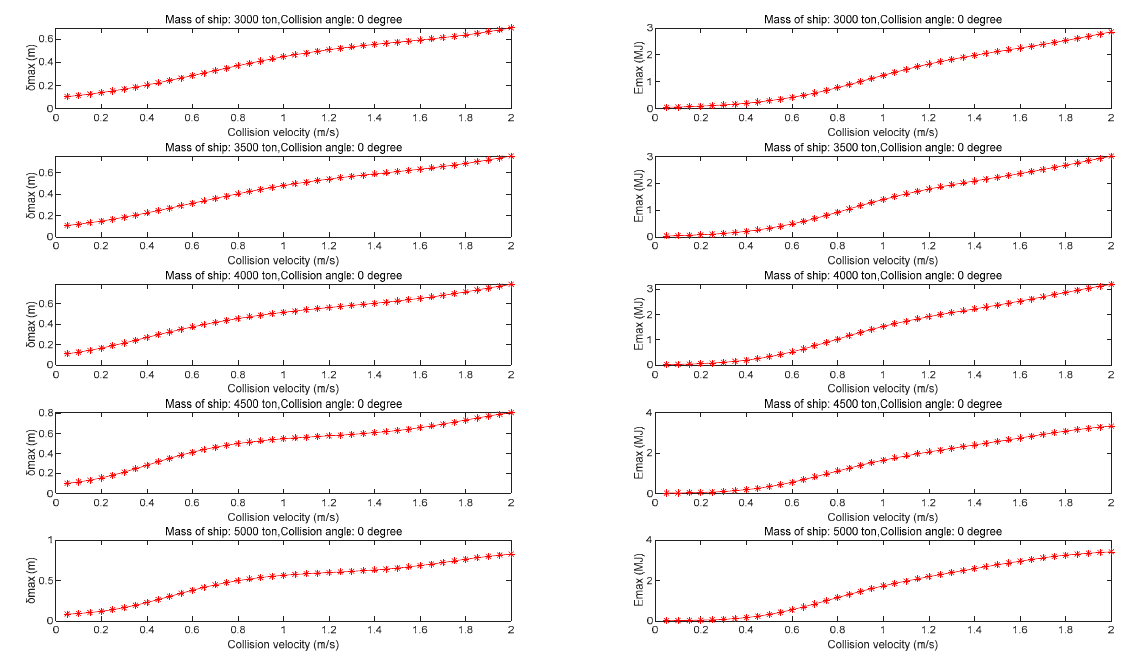
Figure 9. Curves of δ max and E max varying with the collision velocity under 5 different masses of ship.